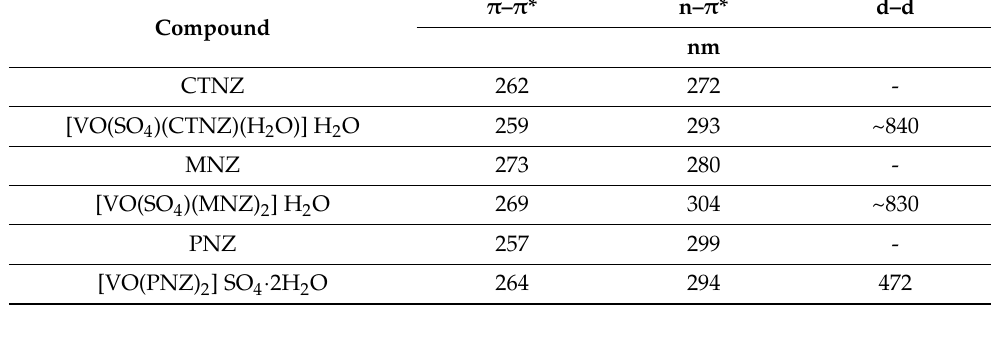
Table 5. Electronic spectral data of the studied compounds.